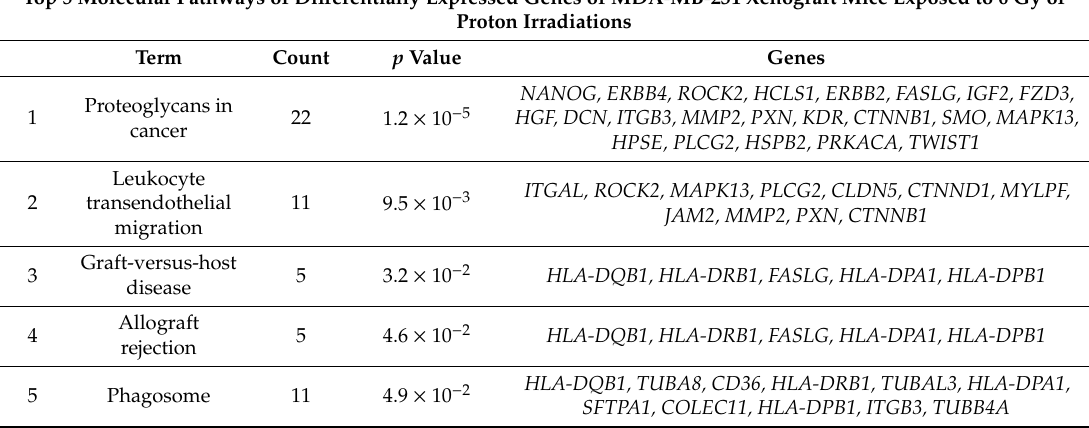
Table 3. GEPs DAVID analysis of MDA-MB-231 xenograft mice exposed to 6 Gy of proton